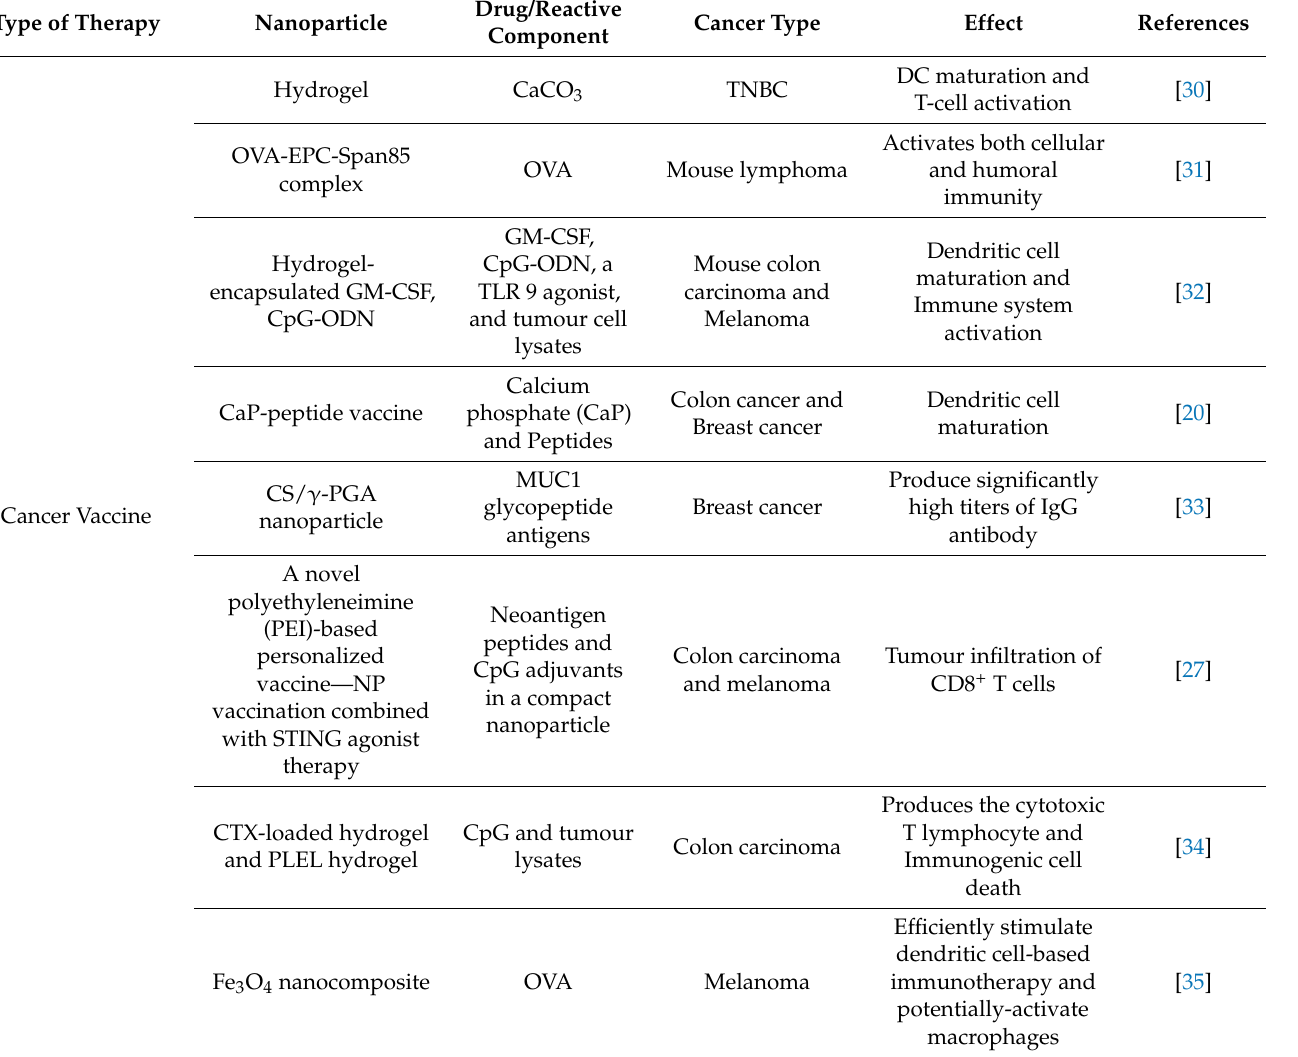
Table 1. Nanocarrier mediated immunotherapy interventions and their effect on various